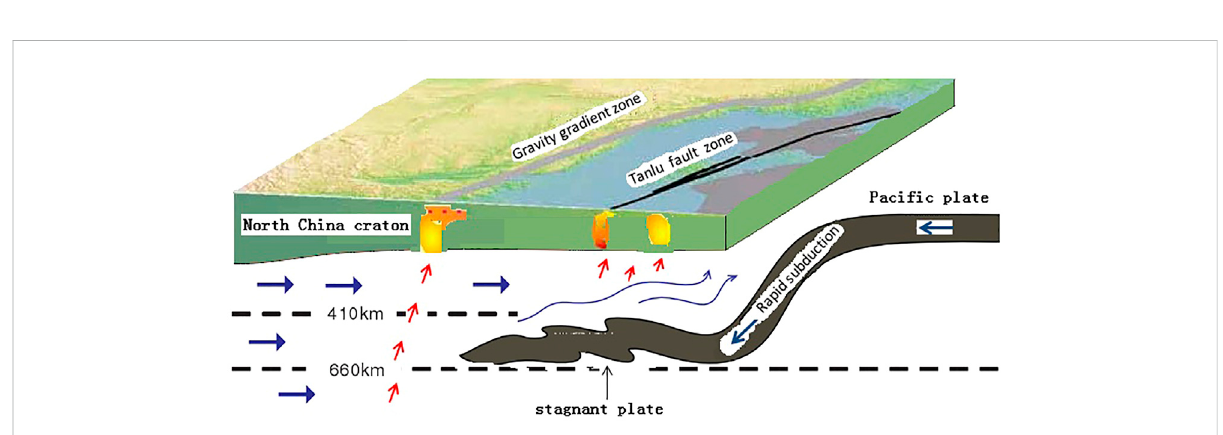
FIGURE 6 Mantle convection mechanism of destruction and transformation of the North China Craton (base map after Zhu et al.,